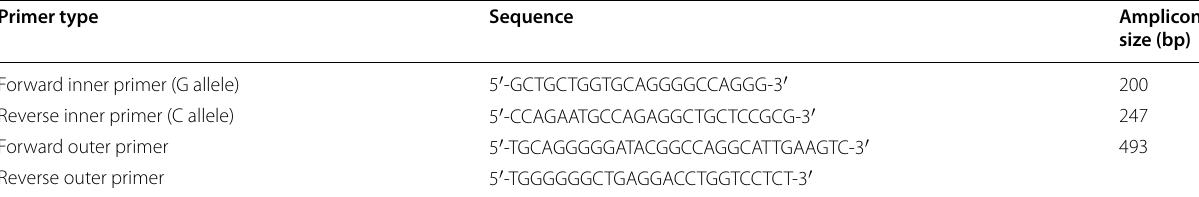
Table 1 Sequences of the tetra primers used in T-ARMS PCR Primer